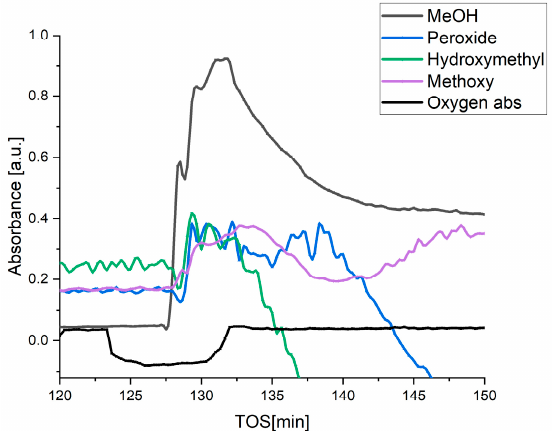
Table 1. Overview of important bands during the ATR experiments.